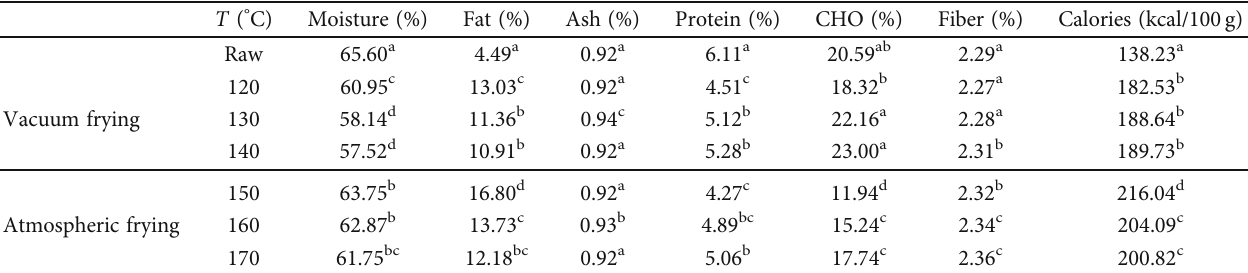
Table 3: Bromatological composition of Carimañolas fried under vacuum and atmospheric